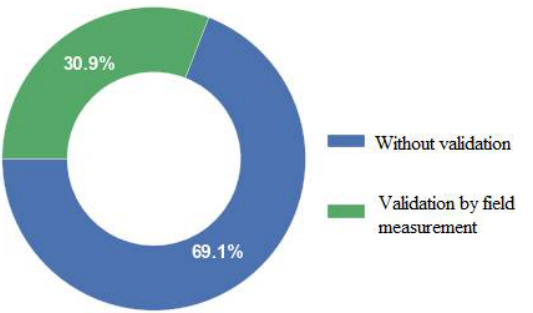
Figure 3. Statistical distribution diagram of the studies that combined CFD simulation and field measurements.